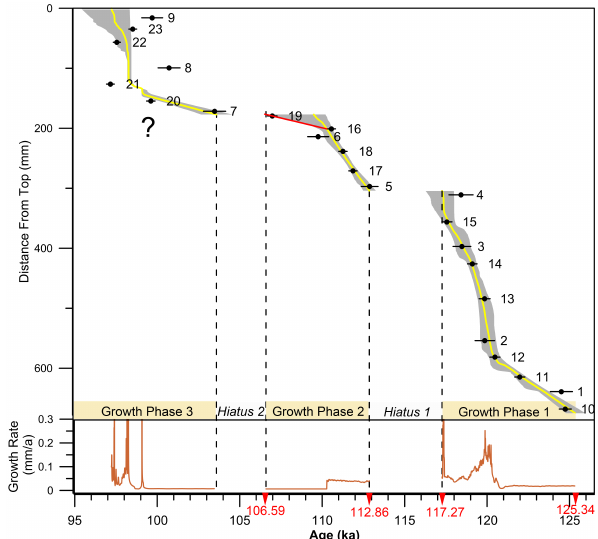
Figure 4. Han-9 age–depth model constructed with the StalAge al- gorithm (Scholz and Hoffmann, 2011). The actual age–depth model is represented by the yellow line; the grey area marks the error (2 σ ). Numbers represent the sample labels (Table 1). The brown curve displays the growth rate. Numbers in red indicate important dates and are discussed in the